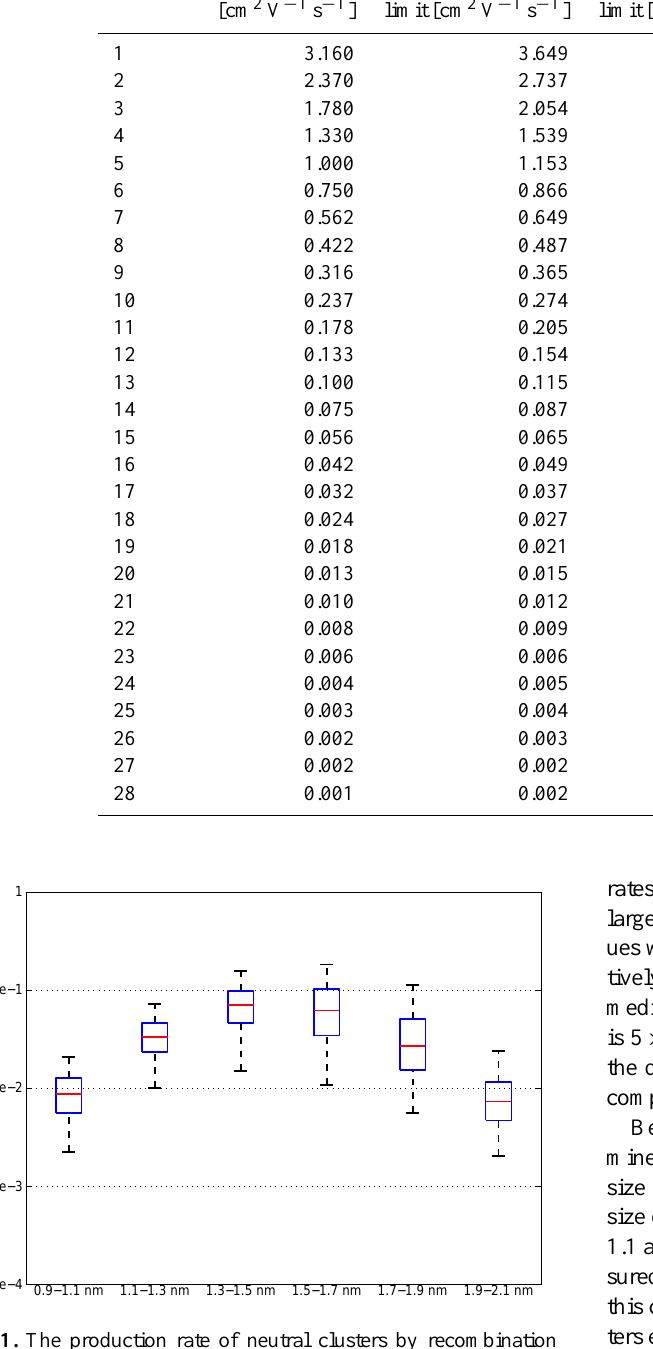
Fig. 1. The production rate of neutral clusters by recombination in different size classes. The red lines show the medians, the blue boxes indicate the 25th and 75th percentiles, and the vertical bars show the 5th and 95th percentiles.